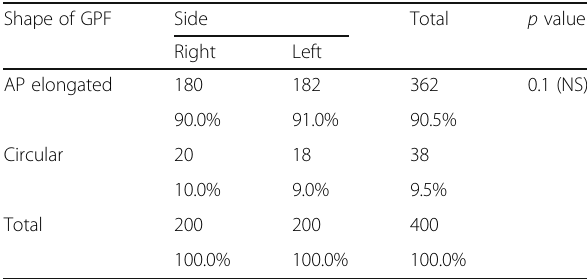
Table 7 Frequency and percent of the shape of the GPF based on